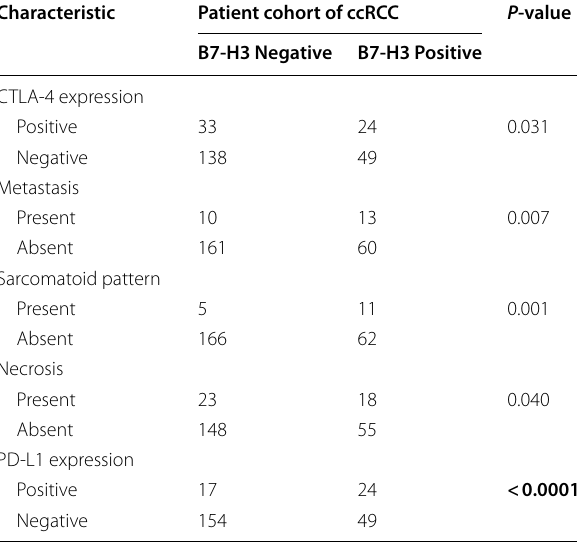
Table 2 Correlation